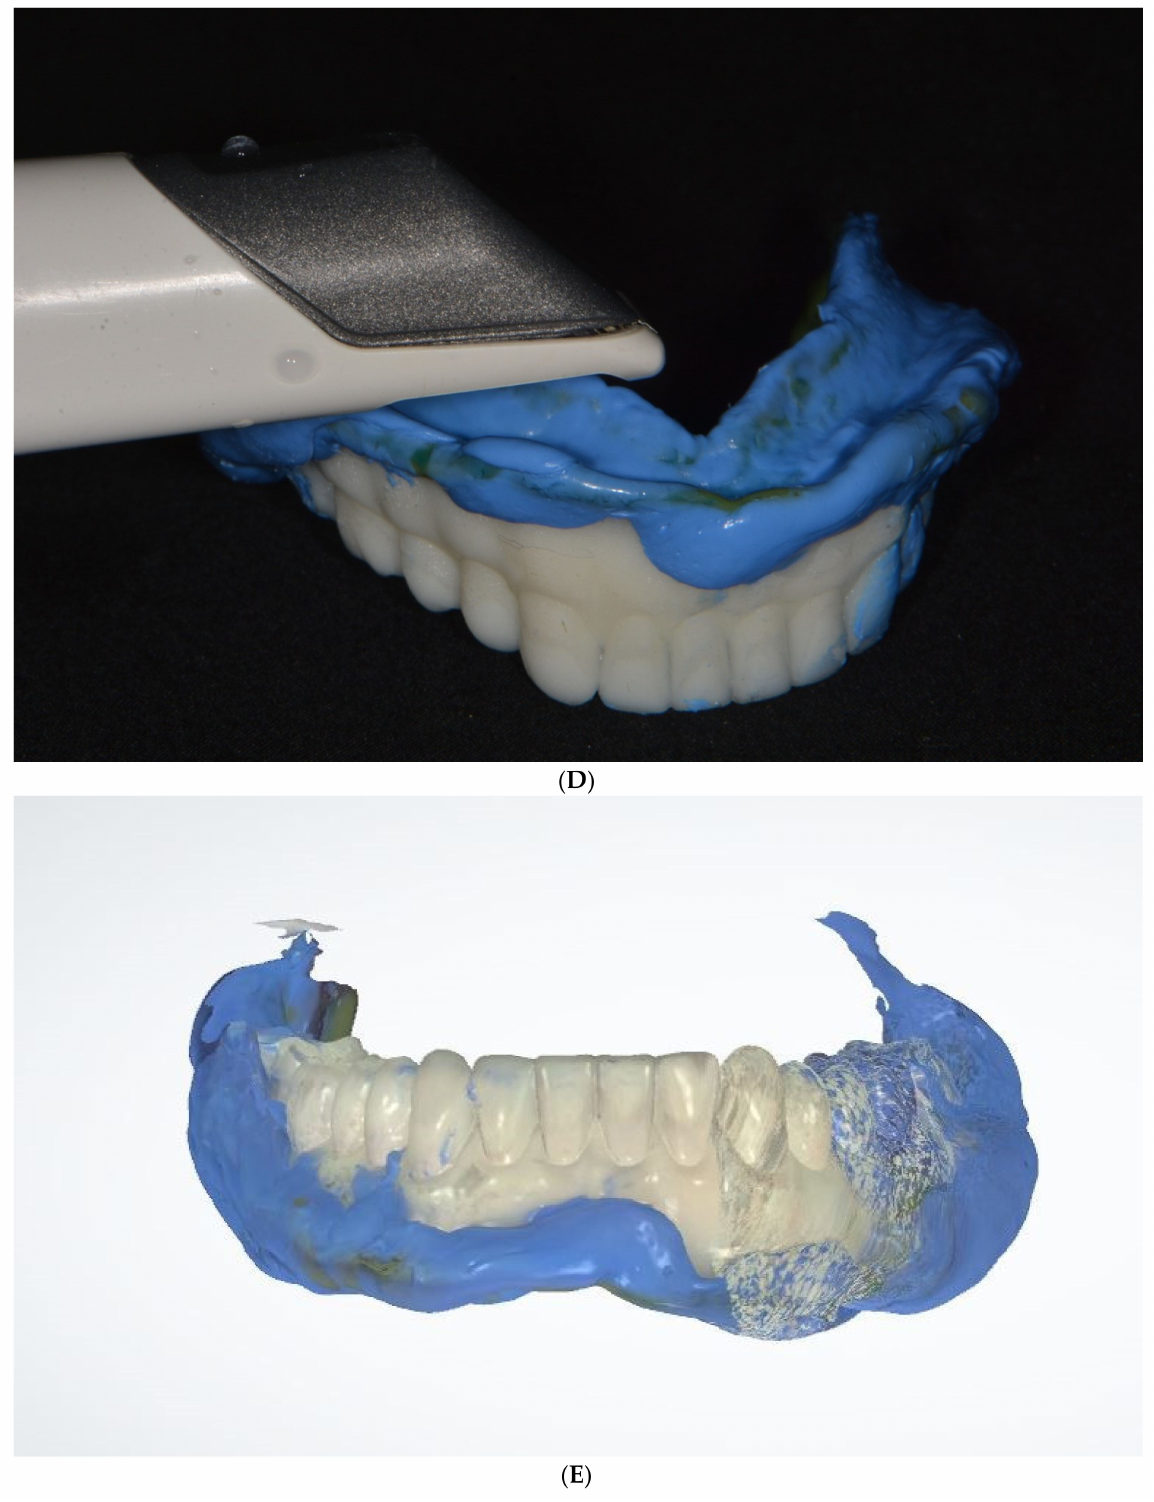
Figure 2. Final impression using trial denture. ( A ): Trial denture borders are approximately 2 mm short of the vestibular reflections. ( B ): Border molding is performed by adding modeling compound to the trial denture borders. ( C ): Final impression is obtained with the border-molded trial denture. ( D ): The trial denture is scanned using an intraoral scanner. ( E ): Scan image of the trial